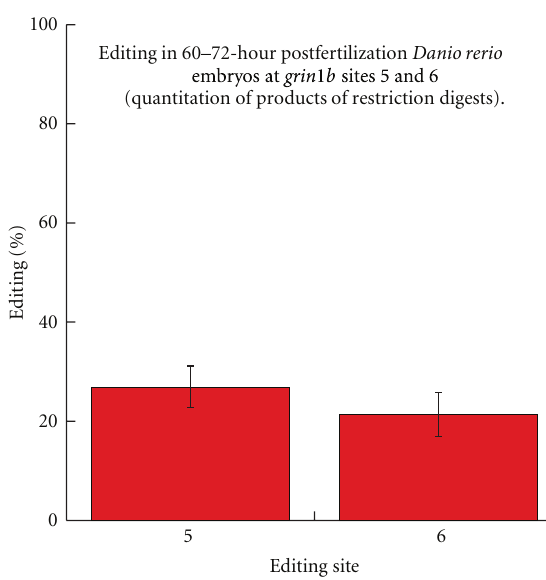
Figure 6: Editing frequencies and error bars (variation). Percent editing at sites 5 and 6 as measured by quantitation of the products of restriction digestion. Bars are standard deviation. Plotted with KaleidaGraph